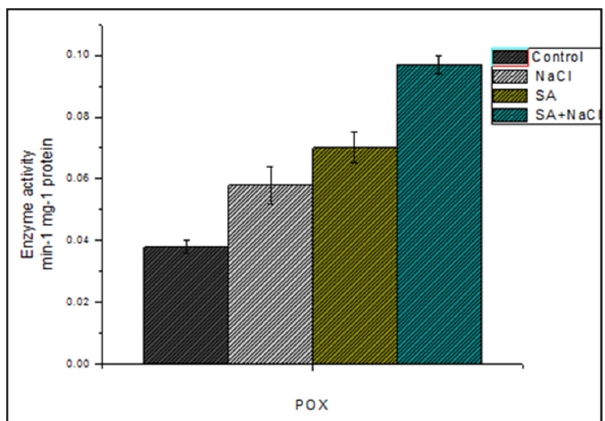
Figure 10. Peroxidase activity: individual and combined effect of salinity and SA on peroxidase activity. X axis -treatment group; Y axis - enzyme activity (min -1 mg -1 protein) Values are expressed as mean ± SD, n=3 in each group. GPX